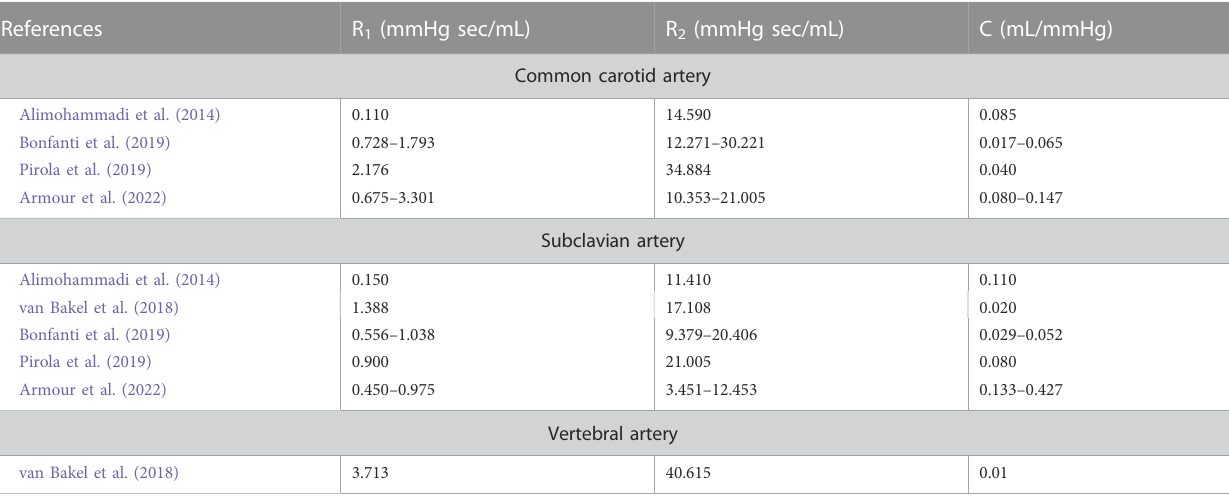
TABLE 3 The R 1 , C, and R 2 parameters extracted from the